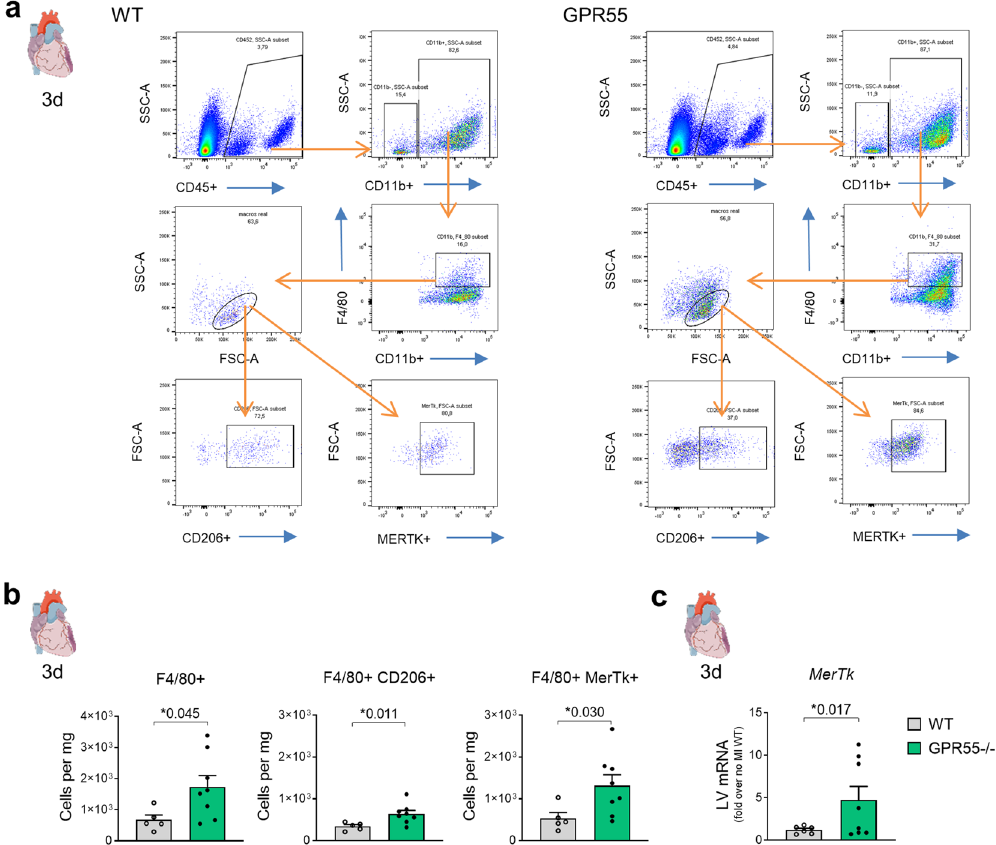
Figure 3. Impact of GPR55 deficiency on cardiac macrophage expansion following MI. ( a ) Representative gating for flow cytometric quantification of F4/80+ macrophages and CD206+ as well as MERTK+ populations in WT and GPR55−/− hearts. ( b ) Quantification of total macrophage counts and subsets 3 days post-MI in WT and GPR55−/− mice. ( c ) LV Mertk gene expression in WT and GPR55−/− mice 3 days post-MI relative to no MI WT. Bars indicate mean ± SE (n = 5–10/group) (Student’s